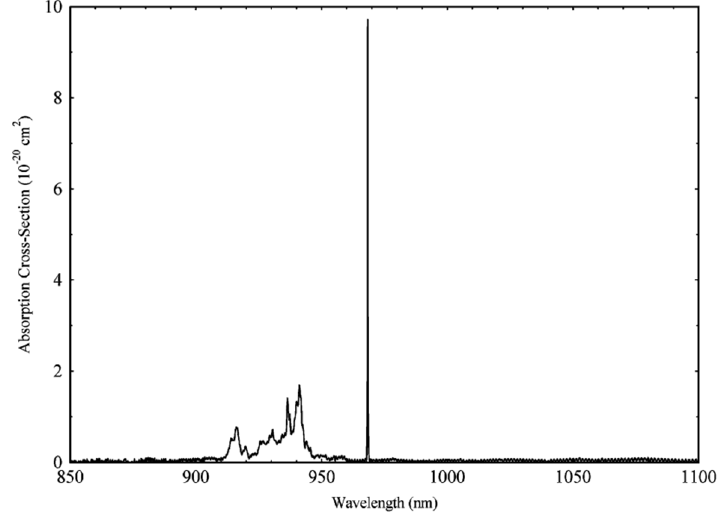
Figure 3. Absorption cross − section of Yb:YAG crystal (0.24 mm thick and 9.8% doping concentration) as a function of wavelength for a crystal temperature of 75 K [12]. Reprinted/adapted with permission from Ref. [IEEE]. 2005, D. C. Brown.